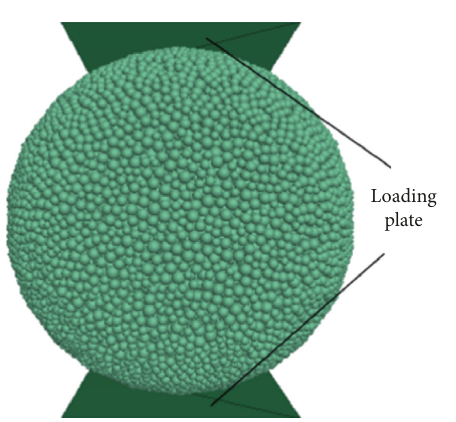
Figure 7: Initial numerical